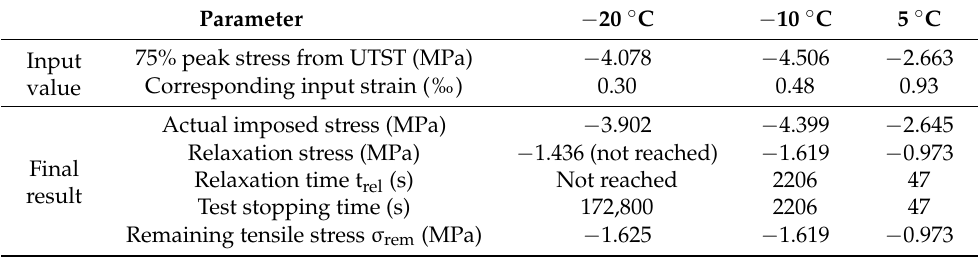
Table 7. Input values and results for the relaxation test of the PMB25